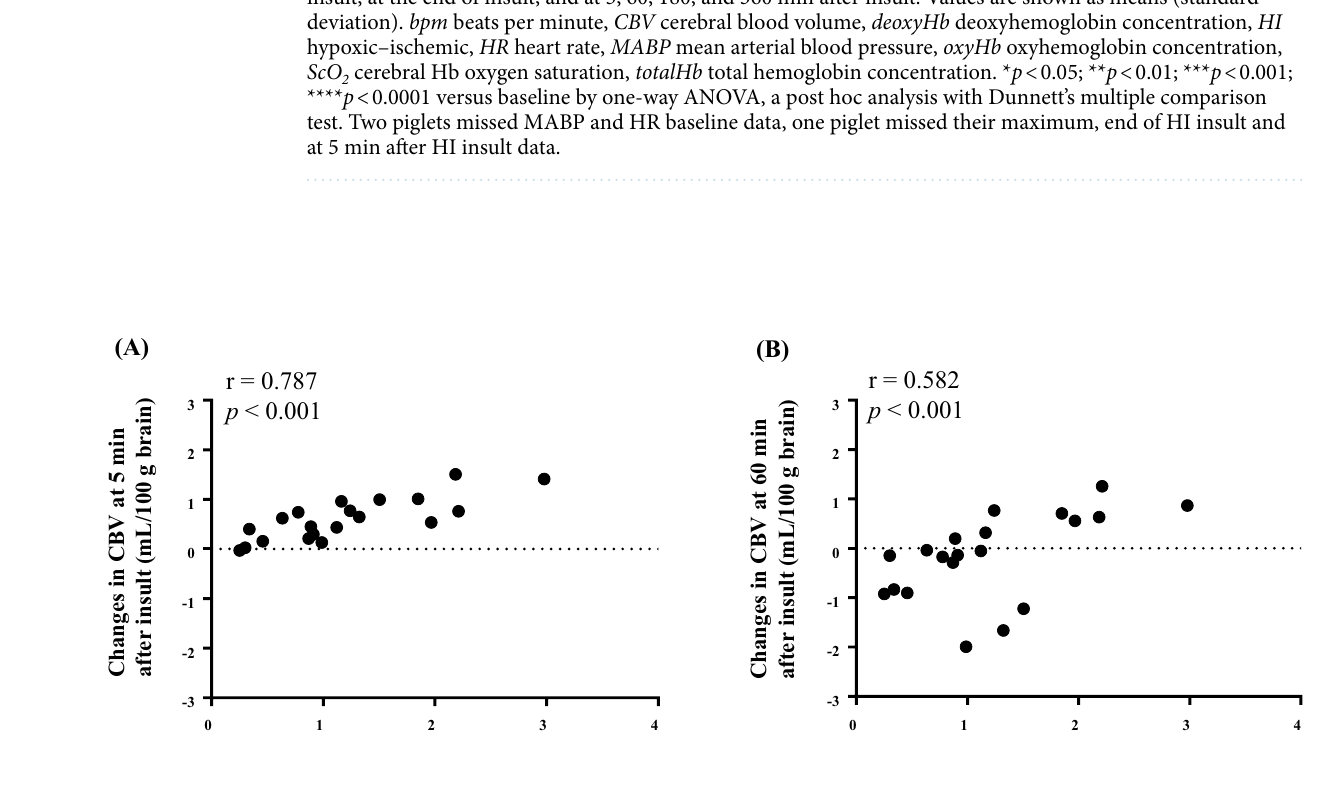
Table 2. Values of oxyHb, deoxyHb, totalHb, CBV, ScO2, MABP and HR at baseline, maximum value during insult, at the end of insult, and at 5, 60, 180, and 360 min after insult. Values are shown as means (standard